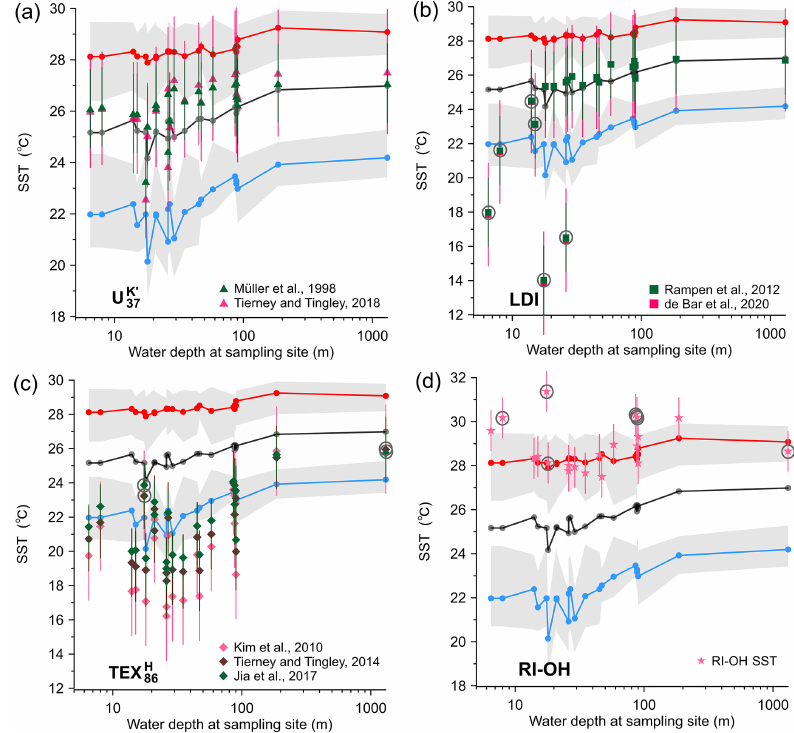
(cid:48) , (b) LDI, (c) TEX H , and (d) RI- 37 86 (cid:48) (triangles), (b) LDI (squares), (c) TEX H (diamonds), 37 86